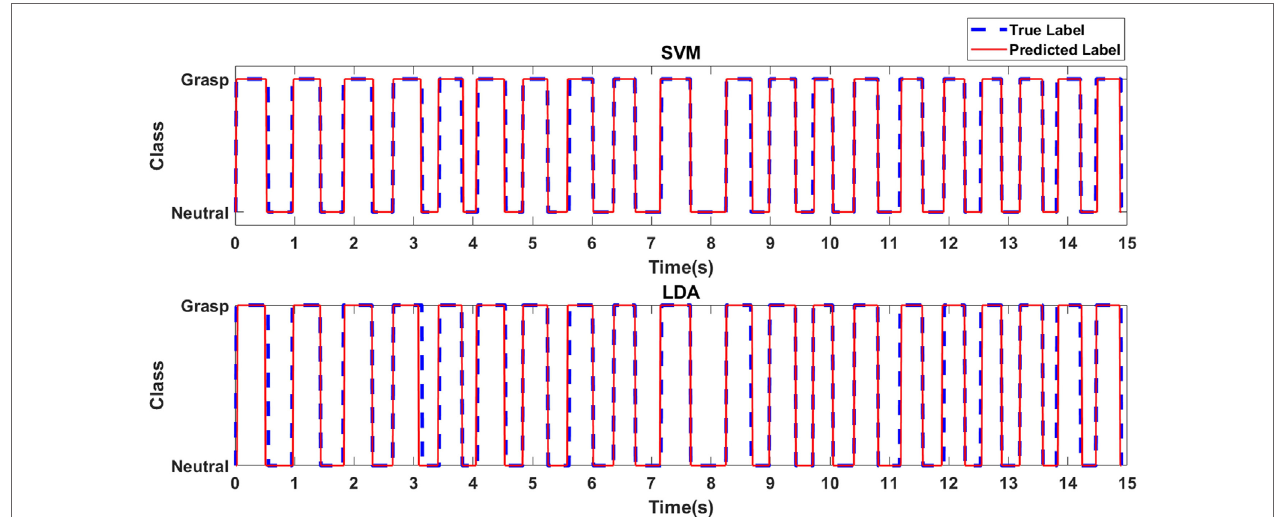
FigUre 4 | Predicted class label in relation to true class label for exemplary case of Task 1 for the first participant with stroke.